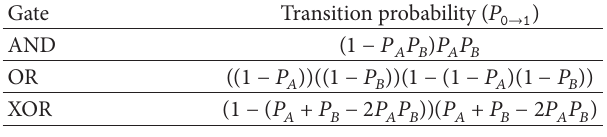
Table 1: Transition probability of XOR gate with basic gates [11].